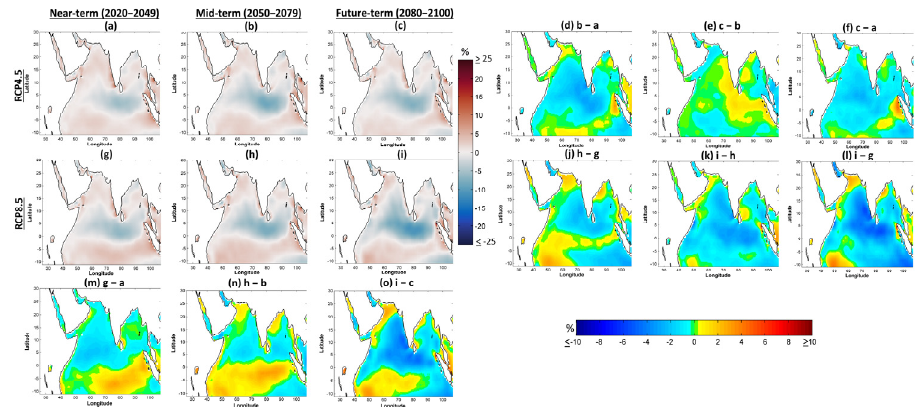
Figure 11. ( a ) For the RCP4.5 scenario, the percentage change in near ‐ term annual mean wind speed estimated from MME ‐ 3_(27,10, and 13) model projections relative to the ERA5 historical time slice (1979 − 2005) over the ocean. ( b ) As in ( a ), but for the mid ‐ term RCP4.5 scenario. ( c ) As in ( a ), but for the future ‐ term RCP4.5 scenario. The difference in percentage change in annual mean wind speed from ( d ) near ‐ term to mid ‐ term, ( e ) mid ‐ term to future ‐ term, and ( f ) near ‐ term to future ‐ term, for the RCP4.5 scenario. ( g − l ) As in ( a–f ), but for the RCP8.5 scenario. ( m ) The difference in percentage change in near ‐ term annual mean wind speed from the RCP4.5 to the RCP8.5 scenario. ( n ) As in ( m ), but for the mid ‐ term. ( o ) As in ( m ), but for the future ‐ term.